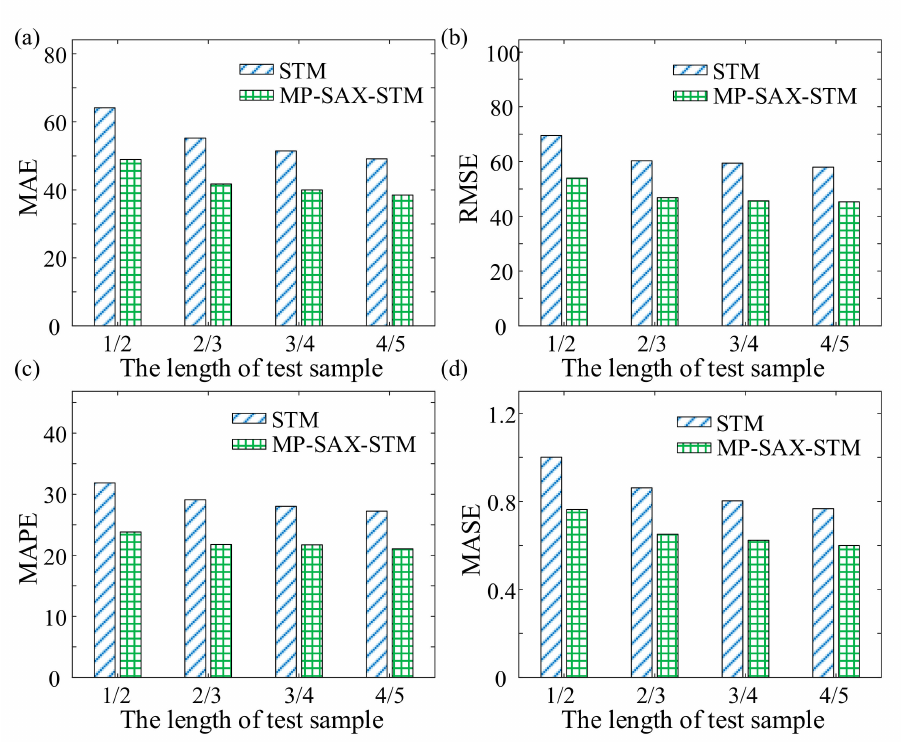
Figure 8. MAE, RMSE, MAPE, and MASE results of Set #2. ( a ) MAE. ( b ) RMSE. ( c ) MAPE. ( d ) MASE.